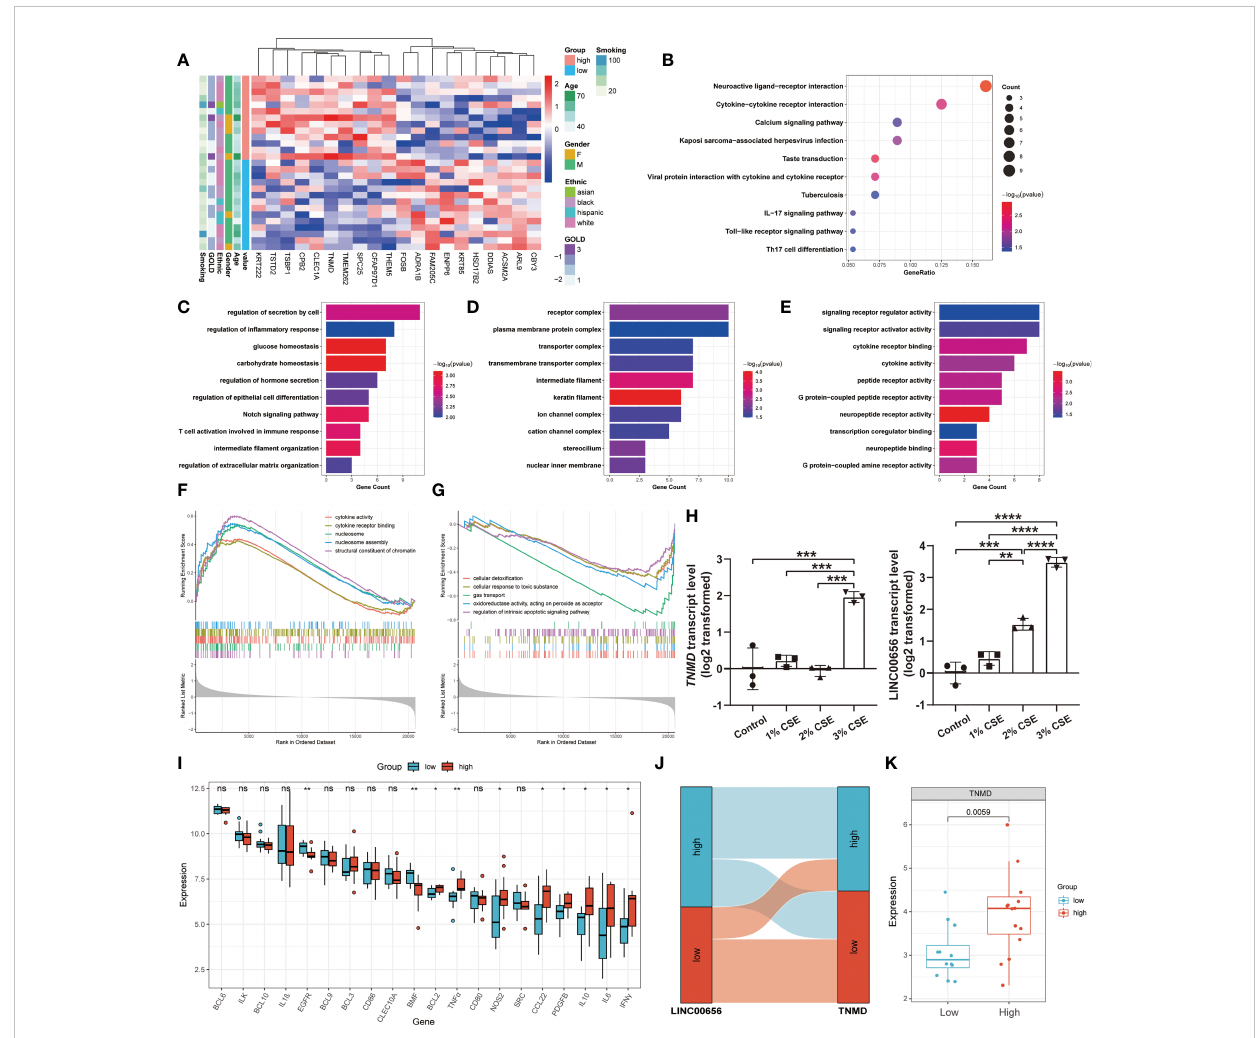
FIGURE 7 The exploration of underlying mechanisms of TNMD in COPD. (A) The expression patterns of COPD patients with high and low TNMD expression were shown in the composite heatmap. Red indicated high expression, while blue indicated low expression. (B) KEGG pathway enrichment analysis revealing key downstream signaling pathways of TNMD. (C-E) GO enrichment annotations of genes correlated with TNMD in three categories: (C) BP, (D) CC, (E) MF. (F, G) GSEA analysis of COPD patients with (F) high TNMD expression and (G) low TNMD expression. (H) The transcript levels of TNMD and LINC00656 in BEAS-2B cells treated with various CSE concentrations (1%, 2%, 3%) for 48 hours were measured by quantitative real-time PCR (qRT-PCR) analysis. Data were presented as the mean ± SD of three independent experiments. (I) The boxplot showing the expression of multiple in fl ammation markers in COPD patients with high and low TNMD expression. (J) The Sankey diagram depicting the relationship between COPD subjects categorized by LINC00656 and TNMD expression. (K) The boxplot showing the expression of TNMD in COPD patients with high and low LINC00656 expression. * P < 0.05; ** P < 0.01; *** P < 0.001; **** P < 0.0001 ns, no statistical signi fi